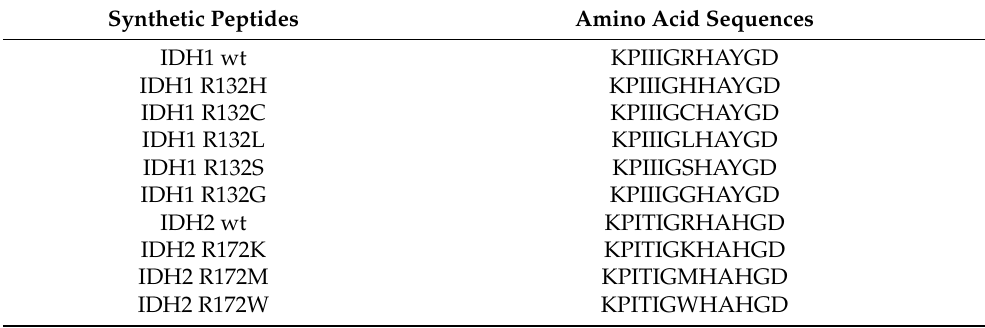
Table 1. IDH1/2 wild-type (wt) and mutant